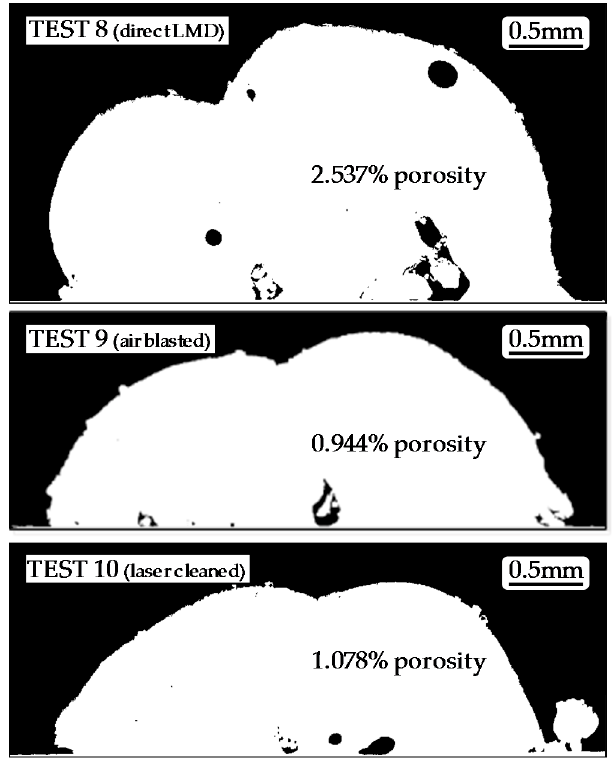
Figure 8. Tests No. 8, 9 and 10—100% concentration cutting fluid tests results.